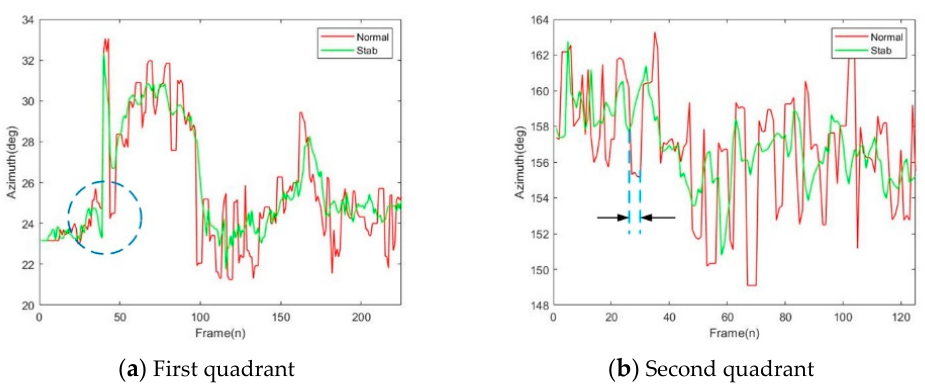
Figure 13. Experiment of the mechanical image stabilization (MIS) and the electronic image stabilization (EIS).